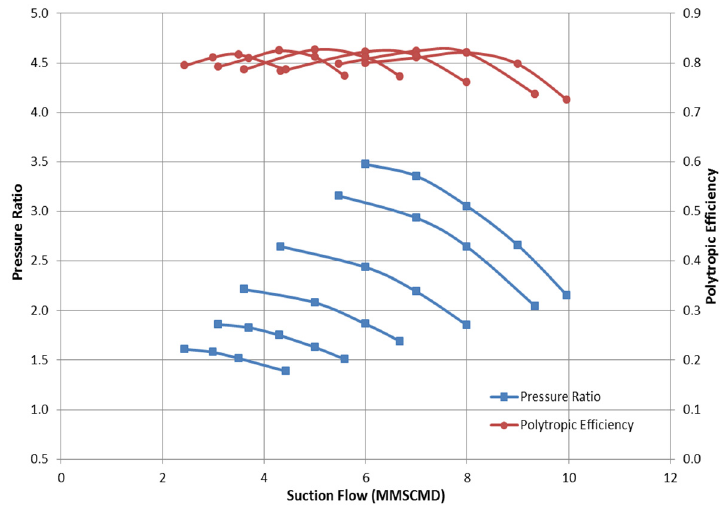
Figure 12. Obtained compressor map based on the measured pressure ratio and efficiency at design